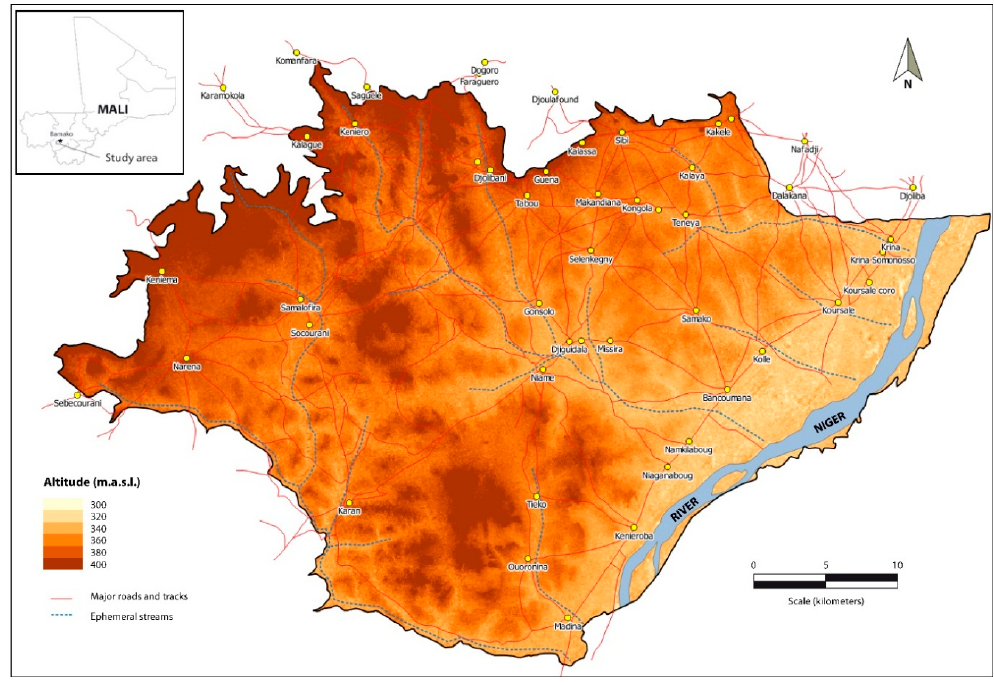
Figure 1. Geographical setting.